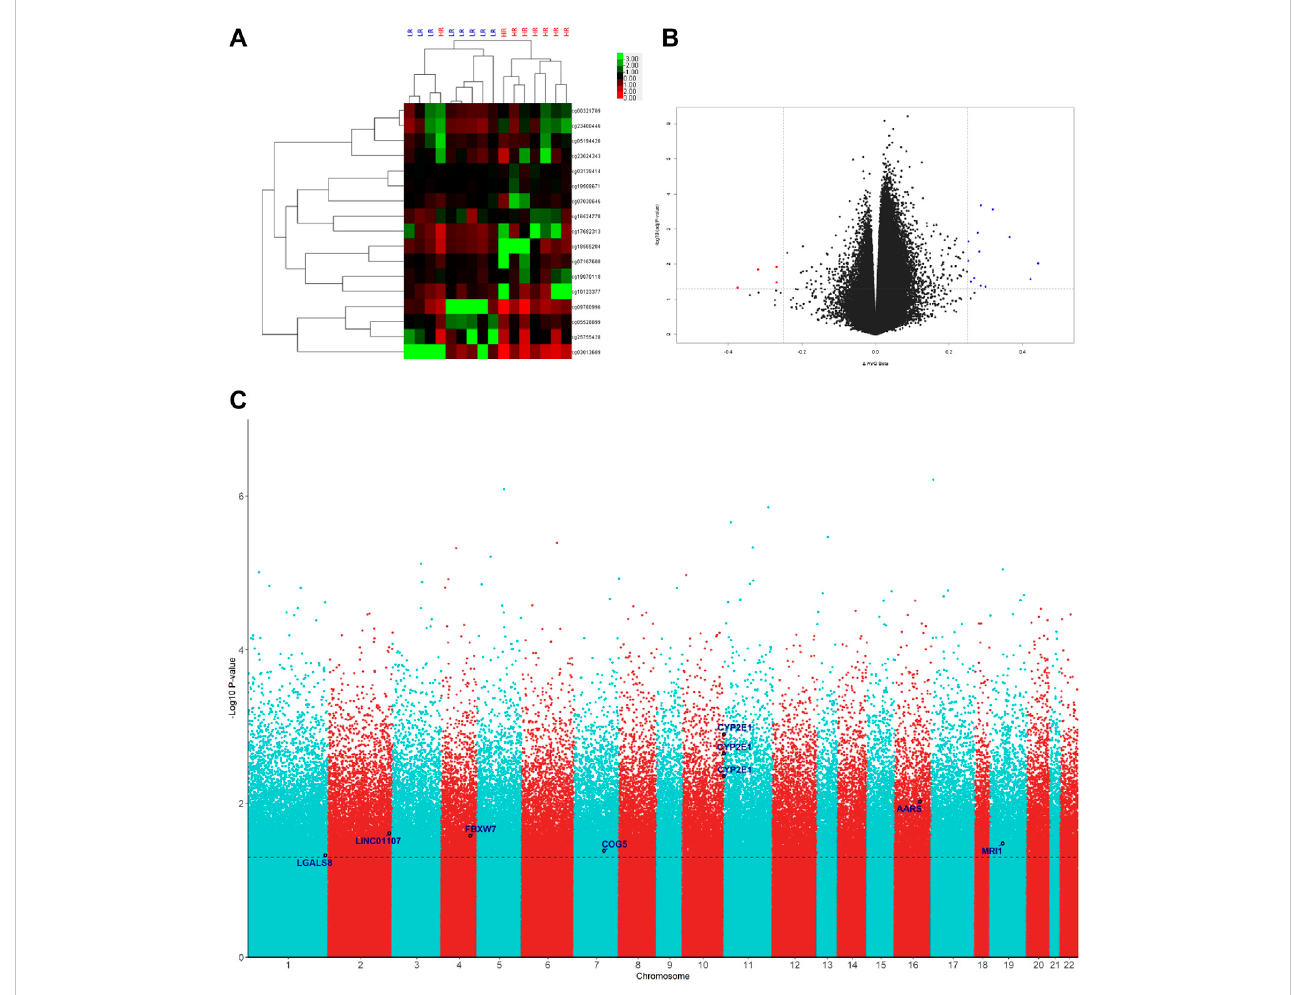
FIGURE 1 Genome-wideDNAmethylationsigni fi cantlyassociatedprobesofLR(lowresilience)versusHR(highresilience)groupsinthediscoveryset. (A) Heatmap of differentially methylated probes with > 25% differences and p < .05 between LR and HR. (B) Volcano plot of differentially methylated probes with > 25% differences and p < .05 between LR and HR. (C) Manhattan plot of differentially methylated probes with > 25% differences and p < .05 between LR and